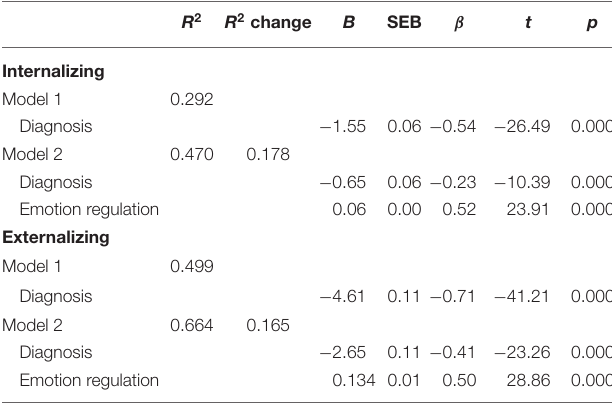
TABLE 4 | Hierarchical multiple regressions of diagnosis and emotion regulation predicting internalizing and externalizing symptoms in the whole